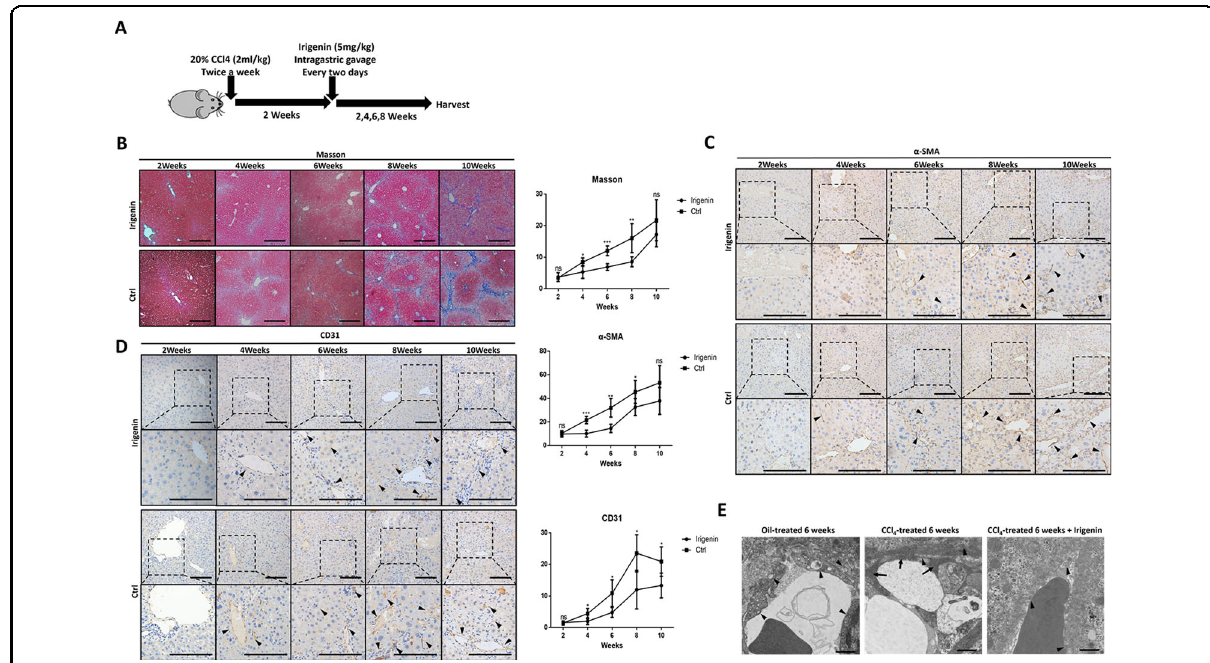
Fig. 6 Irigenin relived mouse CCl4-induced hepatic fi brosis. A Schematic representation of hepatic fi brosis induction in C57BL/6 mice and treated with irigenin. B Masson staining in mouse CCl 4 -induced fi brotic livers treated with irigenin ( n = 3). (Analysis relative area of Masson staining. Data are shown as mean ± SEM; week 2: ns; week 4: * P = 0.0207; week 6: *** P = 0.0003; week 8: ** P = 0.0087; week 10: ns; scale bar = 200 μ m.) C Immunohistochemical analysis of α -SMA expression in mouse CCl 4 -induced fi brotic livers treated with irigenin ( n = 3). (Data are shown as mean ± SEM. Week 2: ns; week 4: *** P = 0.0003; week 6: ** P = 0.0019; week 8: * P = 0.0436; week 10: ns; scale bar = 200 μ m.) D Immunohistochemical analysis of CD31 expression in mouse CCl 4 -induced fi brotic livers treated with irigenin. Irigenin reduced CD31 expression in liver during hepatic fi brosis ( n = 3). (Data are shown as mean ± SEM; week 2: ns week 4: * P = 0.0235; week 6: * P = 0.0169; week 8: * P = 0.0160; week 10: ns; scale bar = 200 μ m.) E Transmission electron microscope (TEM) showing the hepatic sinusoids in the liver tissues. (Short arrows: LSEC fenestrae; long arrows: basement membrane; scale bar = 10 μ